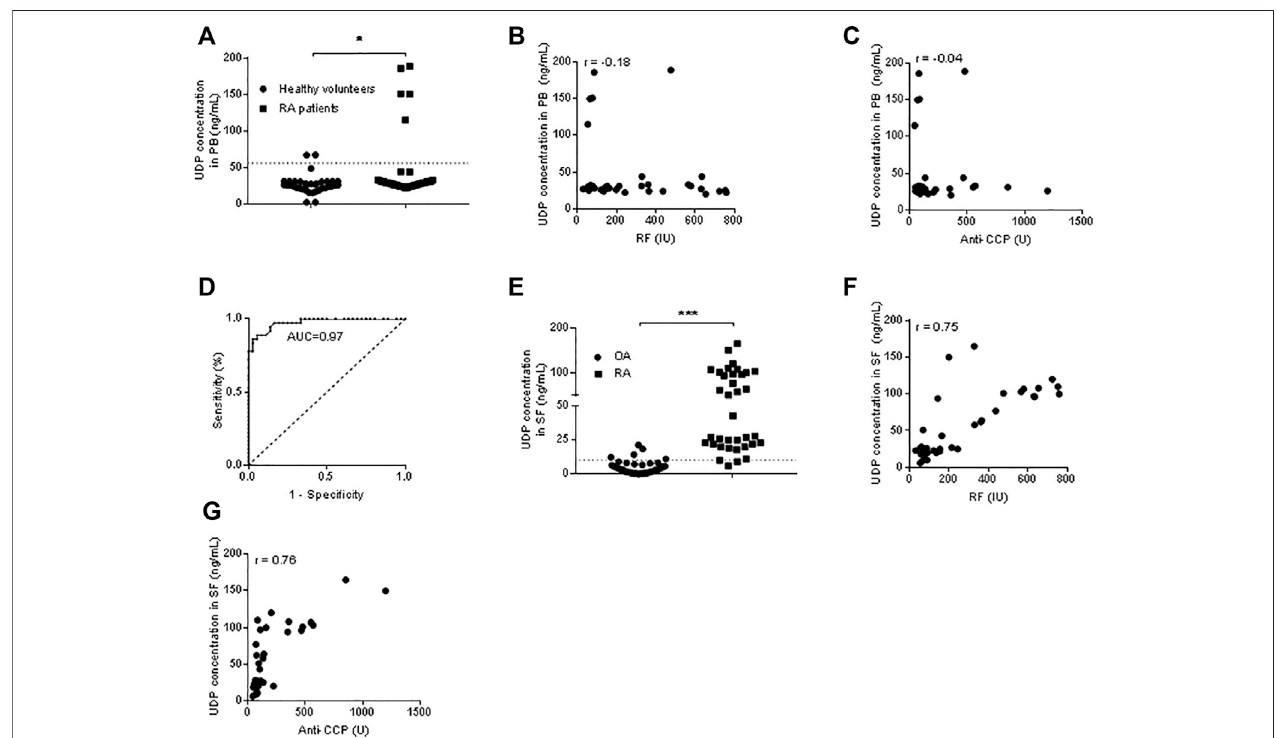
FIGURE 2 | UDP levels in blood and synovial fl uids. (A) The UDP level in peripheral blood ( n (cid:1) 36 for RA patients and healthy volunteers) was measured using a Transcreener UDP assay. (B) Association analysis of the RA blood UDP level with the serum RF level. (C) Association analysis of the RA blood UDP level with the serum anti-CCPlevel. (D) ROCanalysisofUDPinRAsynovial fl uids. (E) TheUDPlevelinsynovial fl uids( n (cid:1) 36forRAandOA)wasmeasured usingaTranscreener UDPassay. (F) AssociationanalysisoftheRAsynovial fl uidUDPlevelwiththeserumRFlevel. (G) AssociationanalysisoftheRAsynovial fl uidUDPlevelwiththeserumanti-CCP level. PB: peripheral blood, SF: synovial fl uids. * p < 0.05, ** p < 0.01 and *** p <